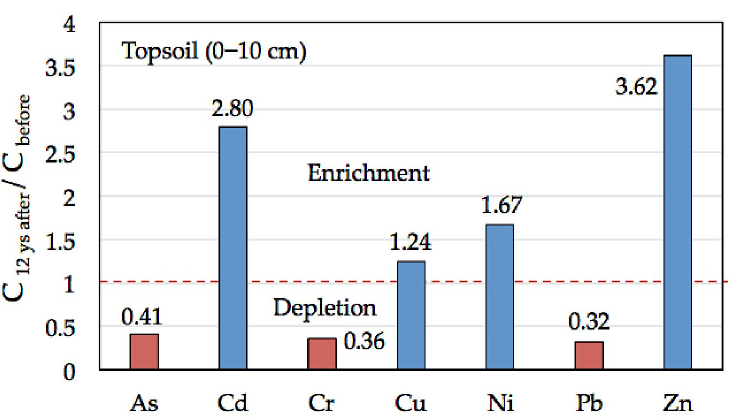
Figure 6. Quotient between total concentration (C) of trace elements in the amended surface soil 12 years after amendment application (this study) and before treatment [24].